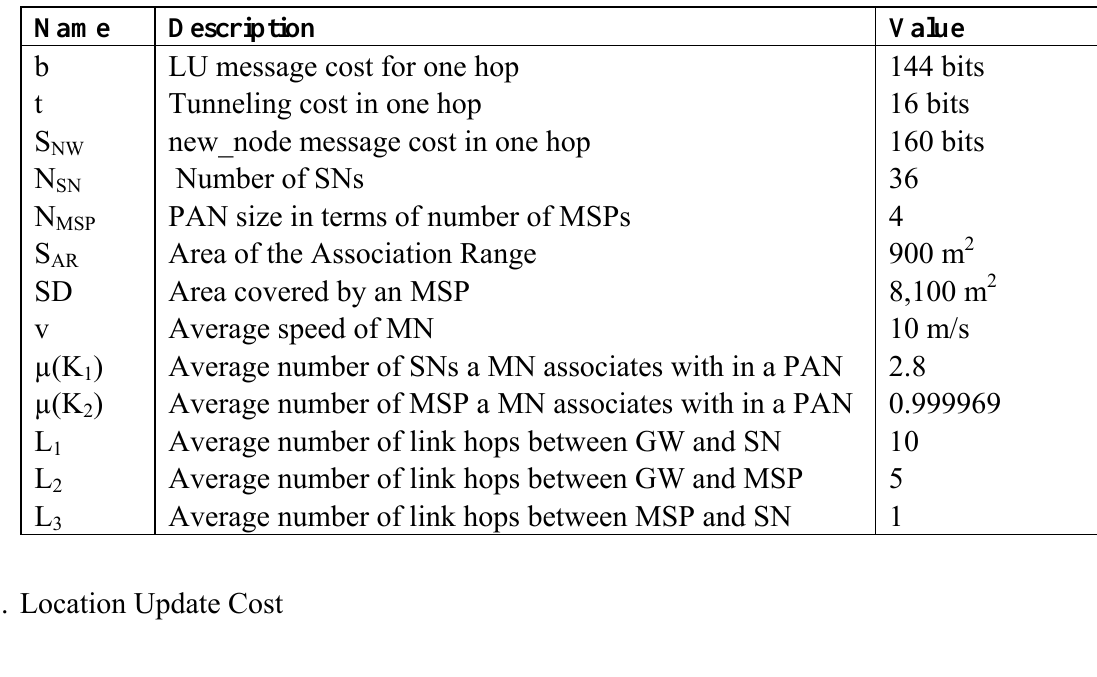
Table 2. The default parameter values for calculation of LU and tunneling